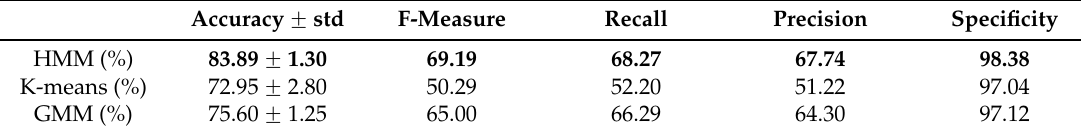
Table 8. Performances of the unsupervised algorithms using extracted features.